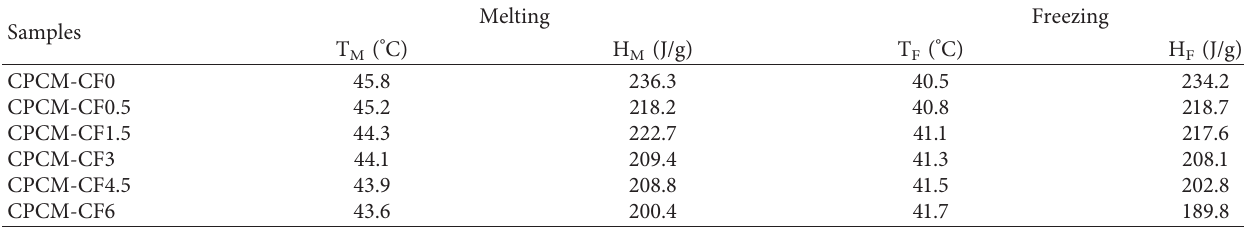
Figure 7: DSC curves of the PCM and CPCM. Table 3: The phase-transition parameters of the